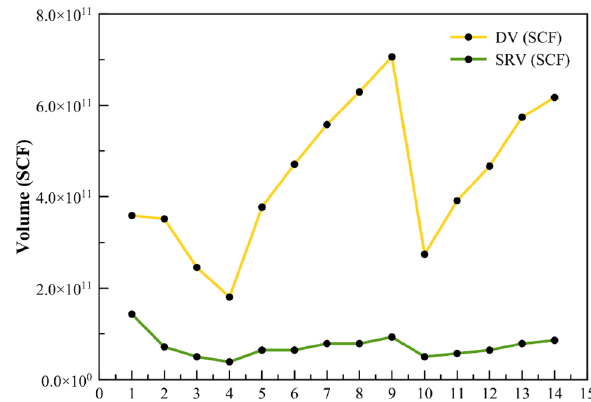
Fig. 12 SRV and DV for correlation modification